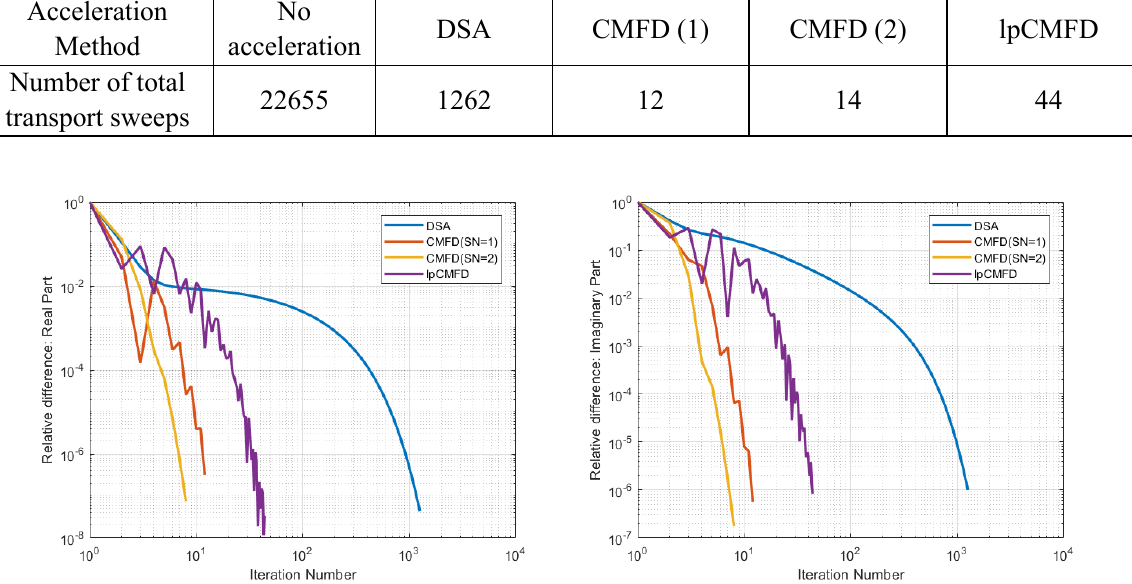
Figure 1 C4V problem - Convergence of the real (on the left) and the imaginary (on the right)